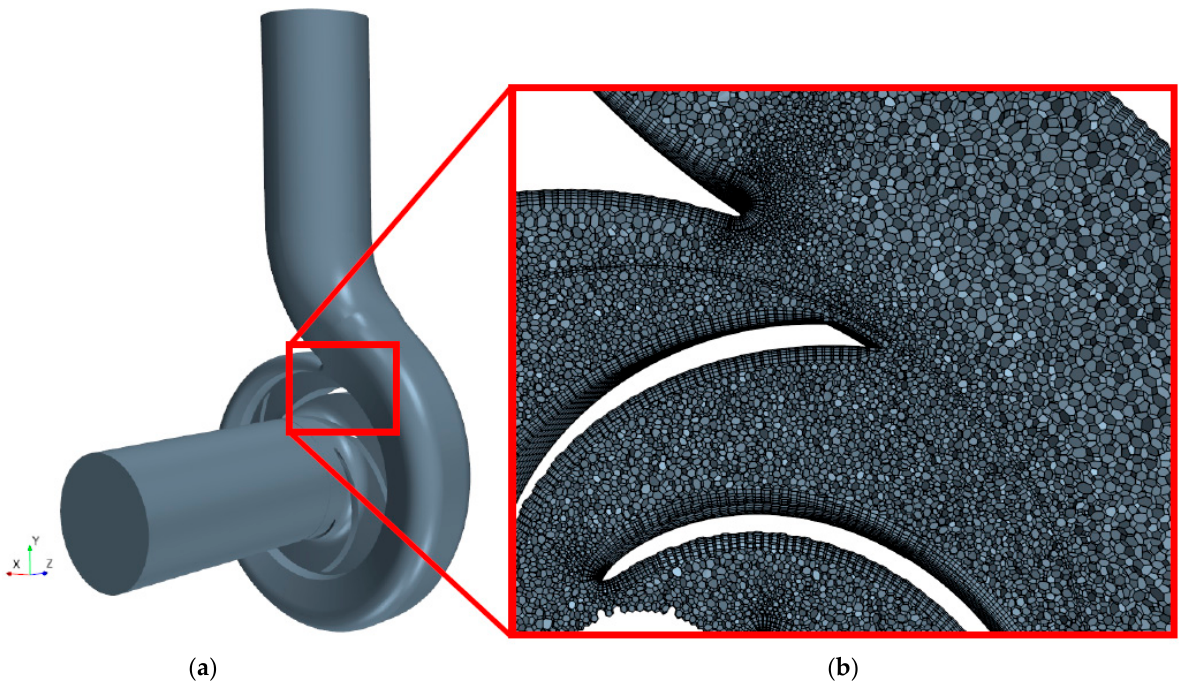
Figure 1. ( a ) Geometric model. ( b ) Polyhedron meshes and prism layers. Table 1. Mesh independence analysis. Mesh